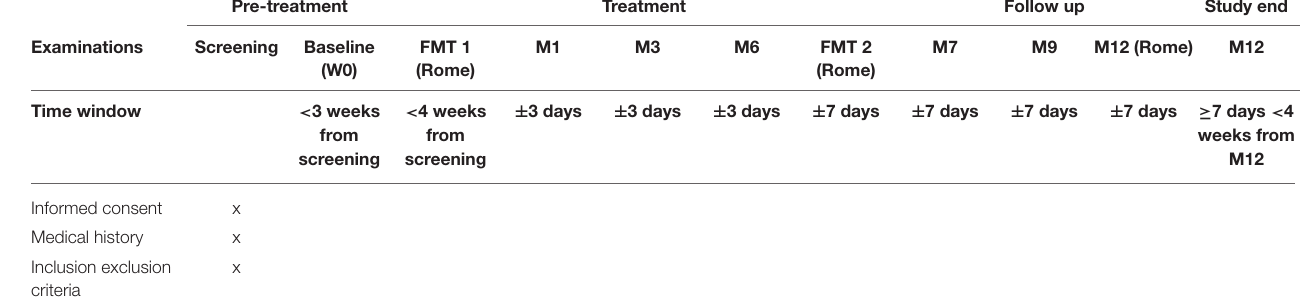
TABLE 3 | Study flow chart. Pre-treatment Treatment Follow